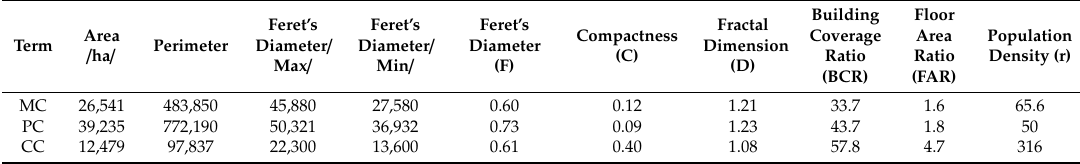
Table 10. Comparison of urban concepts (mc—monocentric, pc—polycentric, cc—compact